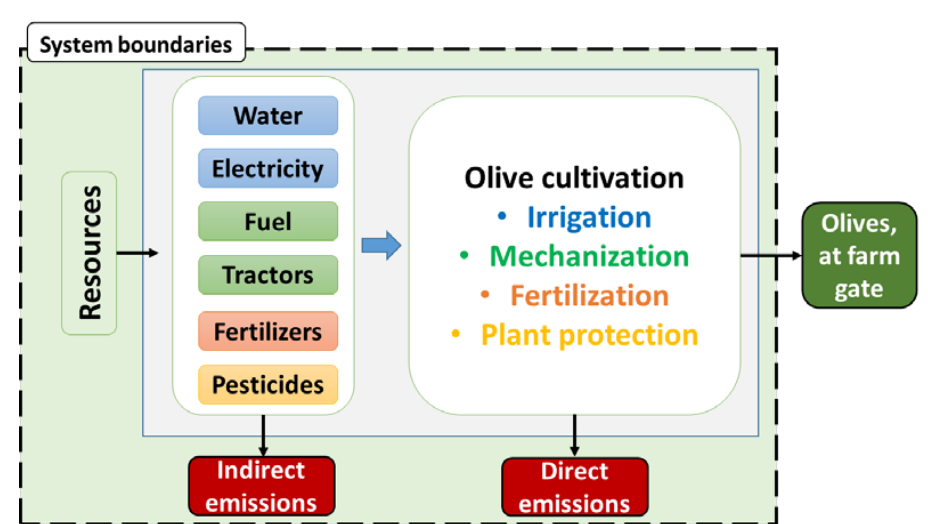
Figure 3. System boundary for LCA of olive production systems.